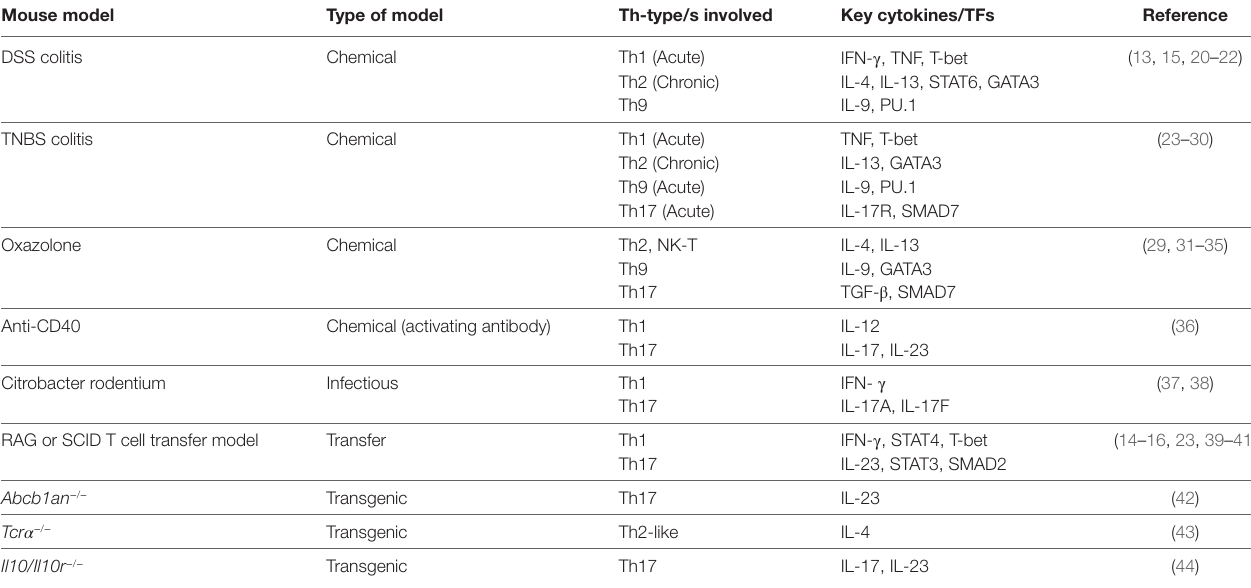
TABLe 1 | Models of Th cell-driven inflammatory bowel